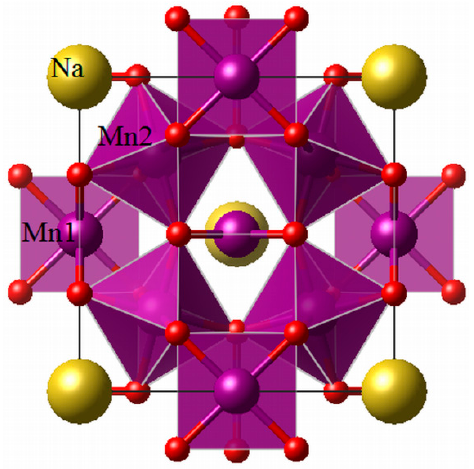
Figure 1. [100] projection of the quadruple perovskite structure having general formula AA’ 3 B 4 O 12 .